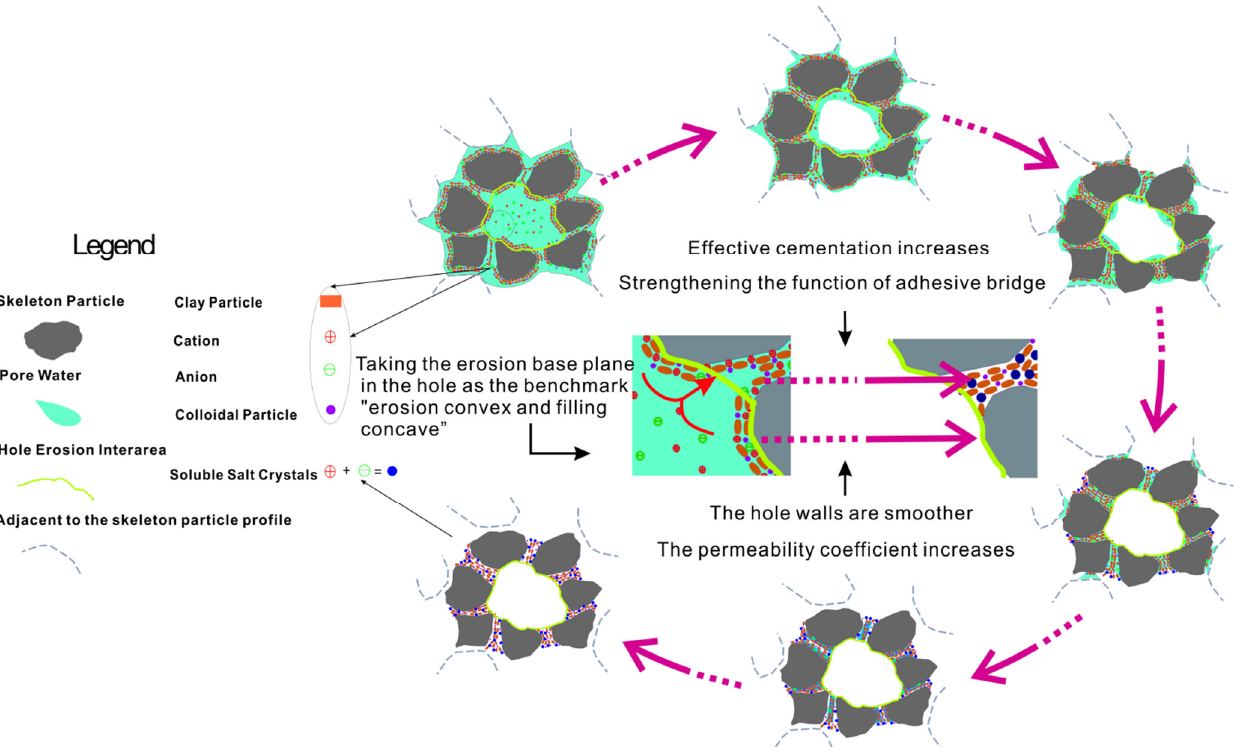
Figure 14. The conceptual model of the effect of drying/wetting cycles on the distribution of effective cementation between loess skeleton particles.